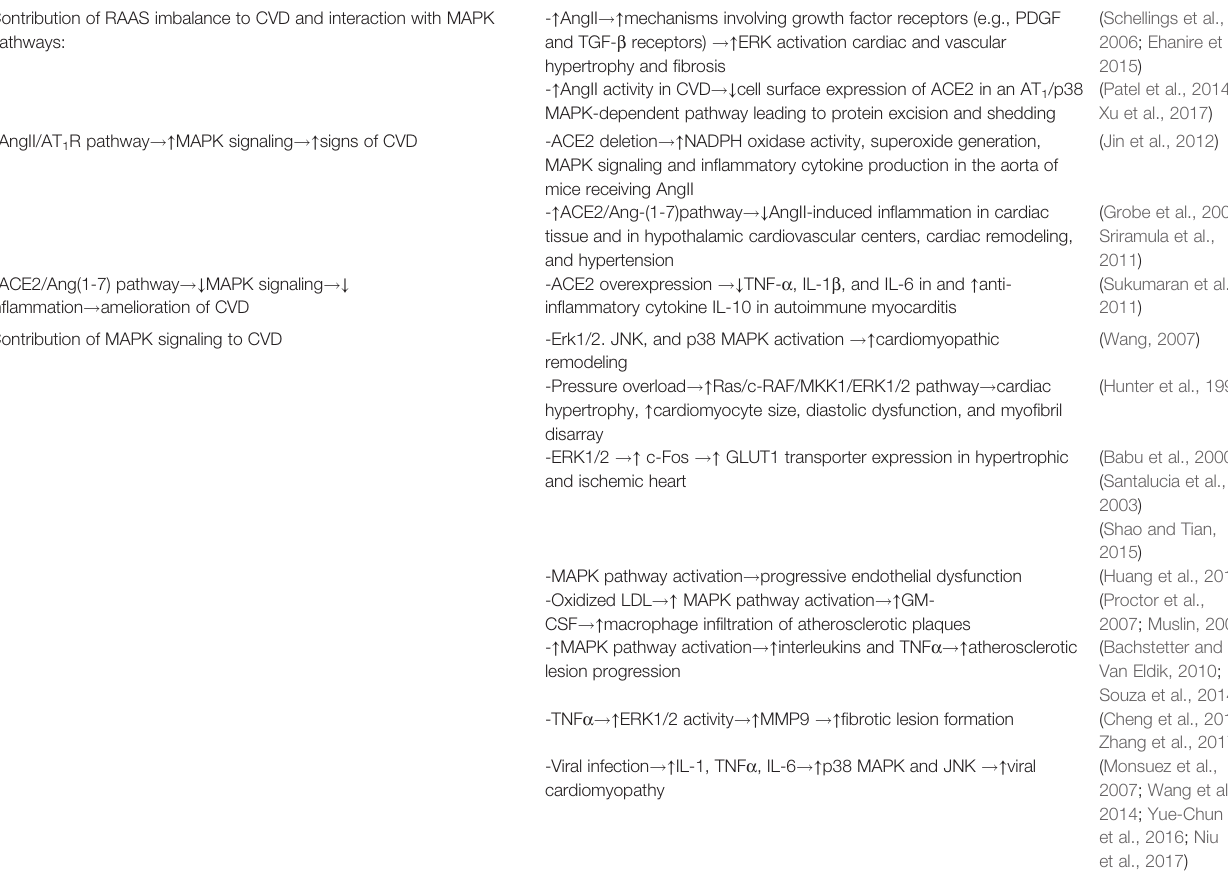
TABLE 1 | Interactions and examples of cardiovascular consequences of RAAS imbalance and MAPK pathway activation Contribution of RAAS imbalance to CVD and interaction with MAPK